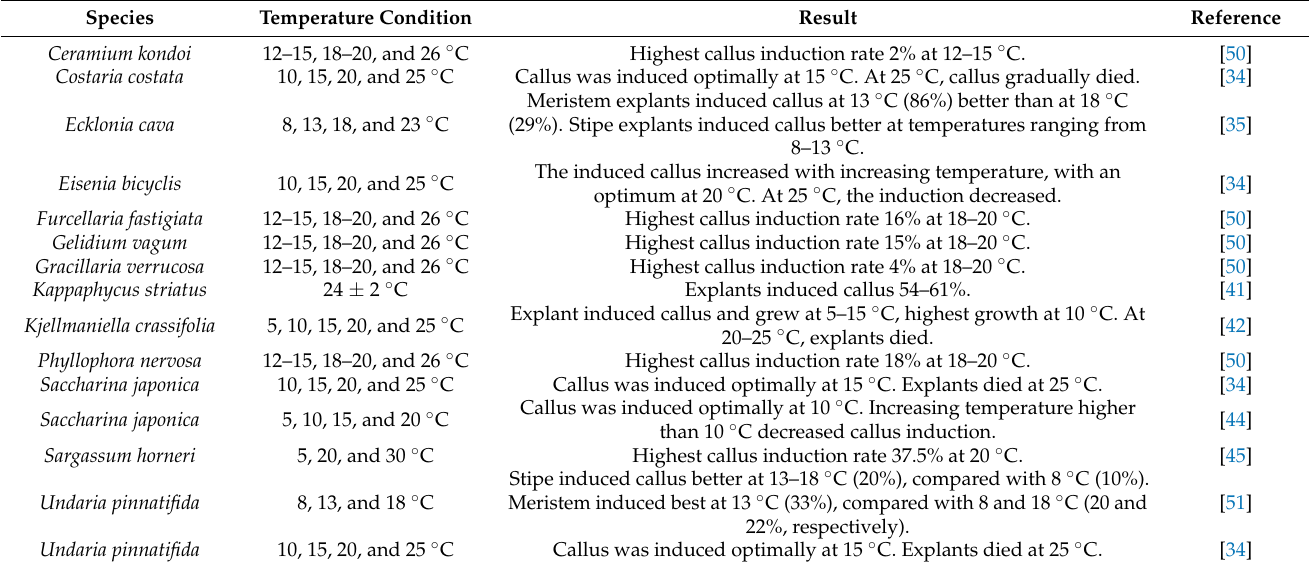
Table 2. Studies on the influence of temperature on callus induction in